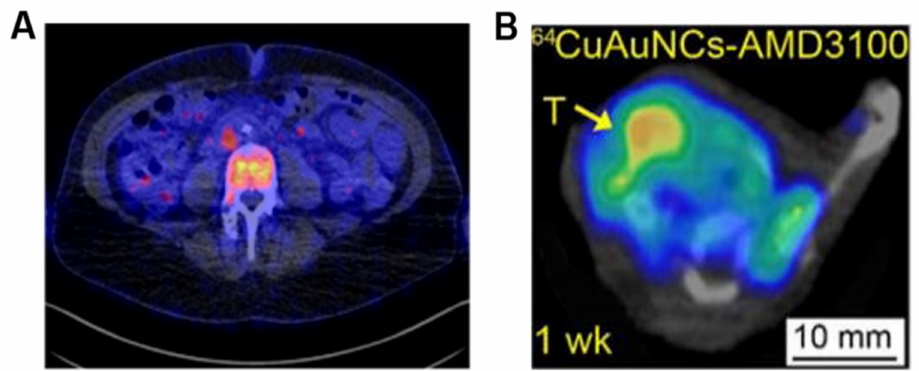
Figure 8. Other radiolabeled molecular imaging probes to detect breast cancer. ( A ) PET/CT image of a bone metastasis in a TNBC patient with heterogeneous intralesional 89 Zr-atezolizumab uptake on day 7 post-injection [205]. ( B ) representative PET/CT image of 64 Cu-AuNCs-AMD3100 showing the tracer accumulation in a 4T1 tumor model at 1 week post-tumor implant